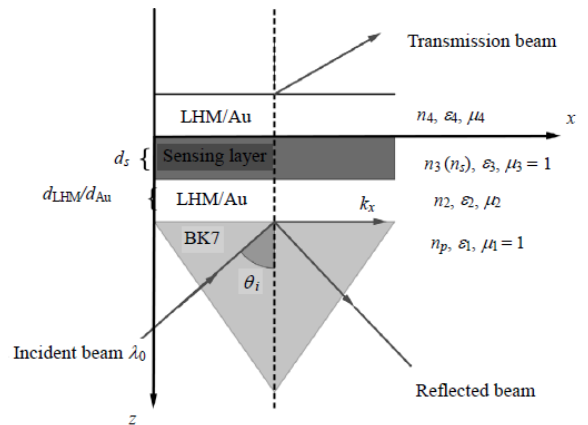
Fig. 1 Schematic illustration of the composite waveguide sensor under